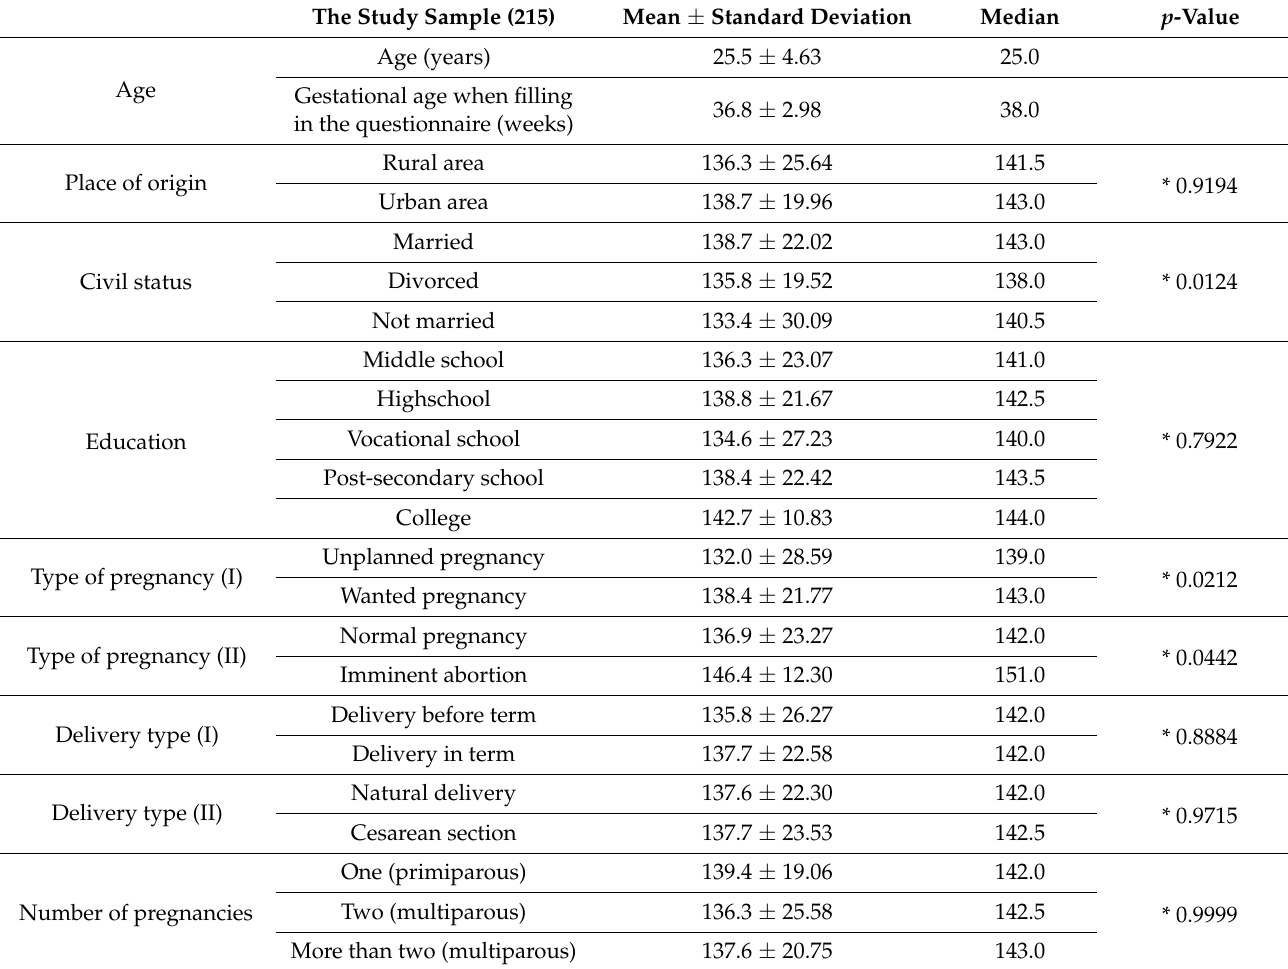
Table 1. Mean ± SD, median and p -values of irrationality score